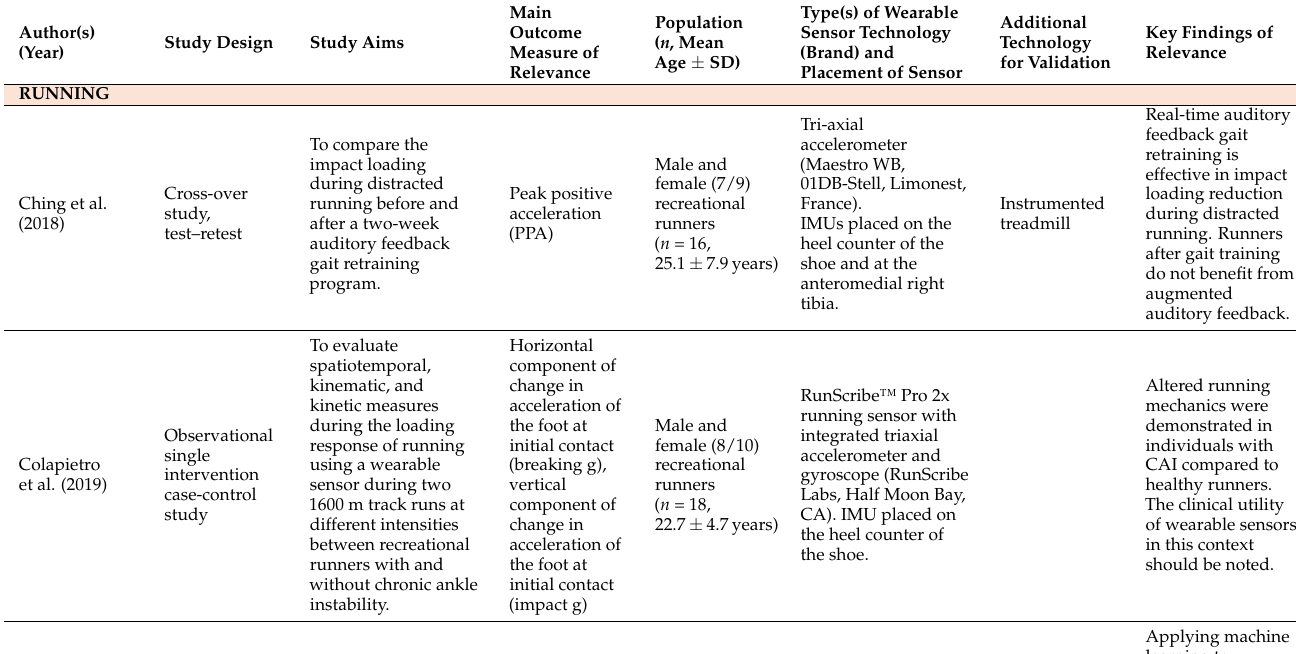
Table 1. Synthesis of results from included papers ( n =